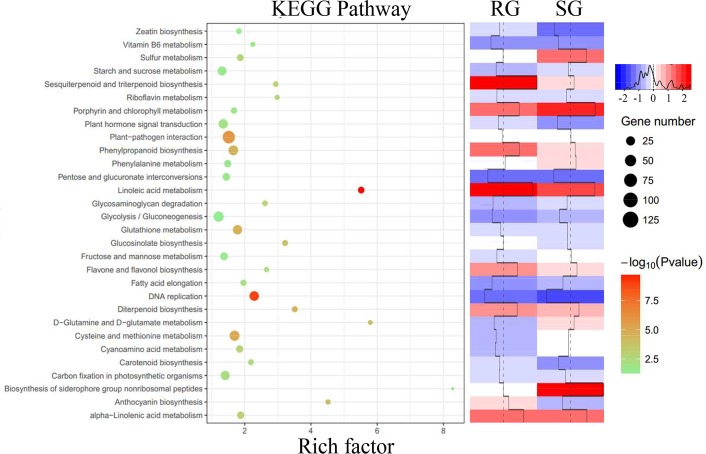
KEGG pathway analysis of differentially expressed genes.The color and size of the dots in the scatterplot represent the range of the negative log10-transformed P-value and the gene number, respectively. The heat map on the right showing the overall expression levels of enriched pathways.